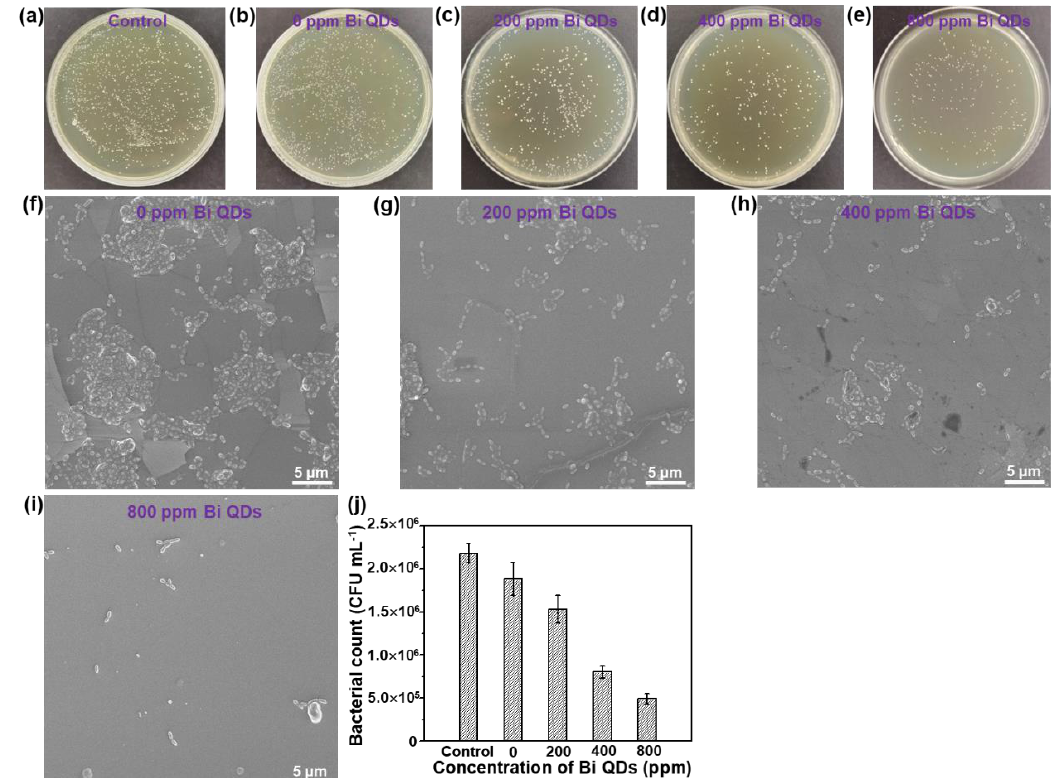
Figure 5. The influence of the Bi QDs content in the Bi QD/PDMS nanocomposite on the antibacterial performance. Plate photographs of S. mutans after incubated for 24 h under dark: ( a ) control, ( b ) 0 ppm Bi QDs, ( c ) 200 ppm Bi QDs, ( d ) 400 ppm Bi QDs, and ( e ) 800 ppm. SEM image of S. mutans under dark: ( f) control, ( g ) 0 ppm Bi QDs, ( h ) 200 ppm Bi QDs, ( i ) 400 ppm Bi QDs, and ( j ) 800 ppm. ( k ) Data statistics from the SEM image.